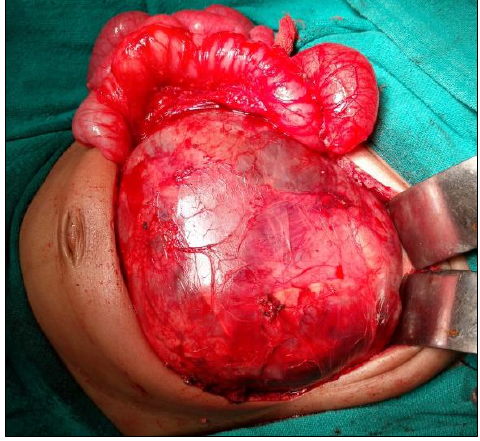
Figure 2: Retroperitoneal teratoma engulfing left kidney. The post-operative period was uneventful. The patient has been doing well on 7 months follow-up with no clinical, radiological and biochemical evidence of any